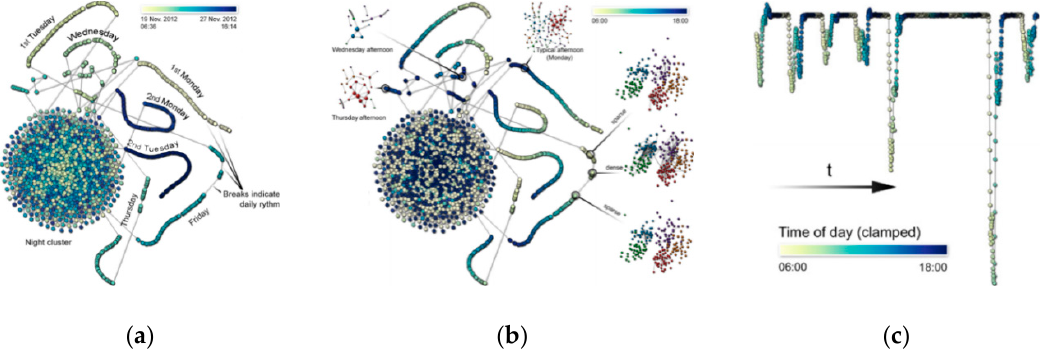
Figure 28. Dynamic trajectory-data visualization of high-dimensional projections from analyzing